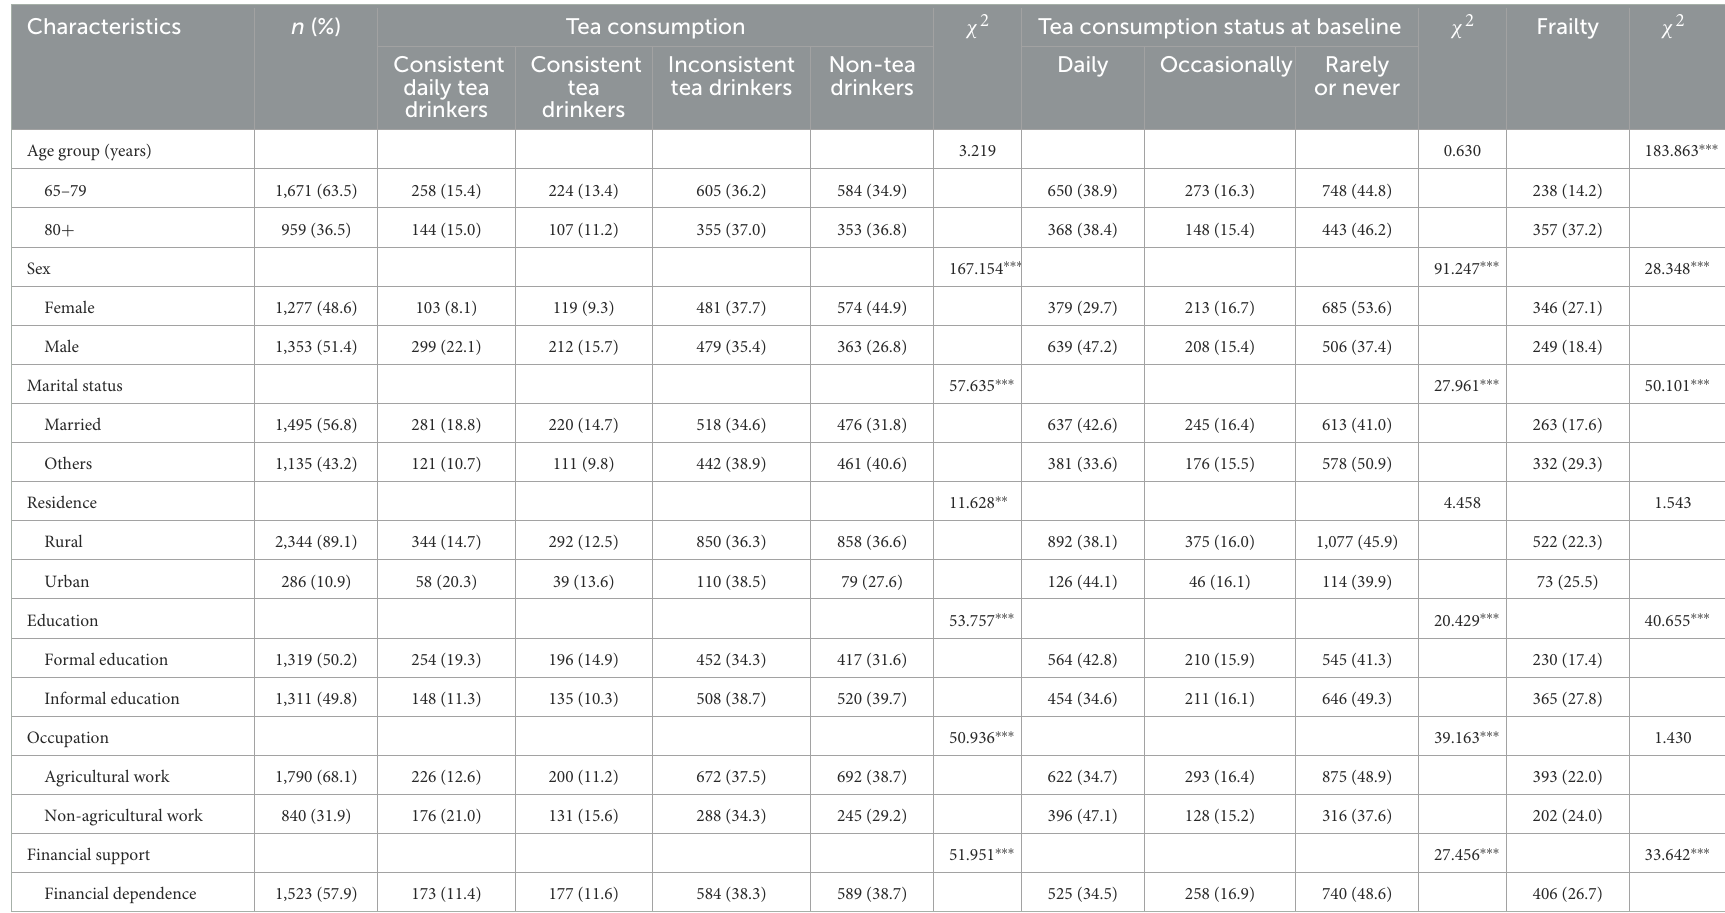
TABLE 1 Characteristics of older adults by tea consumption, tea consumption status in 2008 baseline, and frailty in the 2014 follow-up.